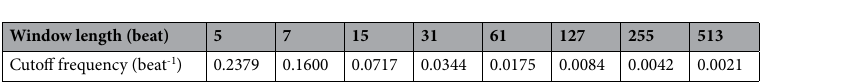
Table 1. The cutoff frequency of the Savitzky-Golay filter of different window length.